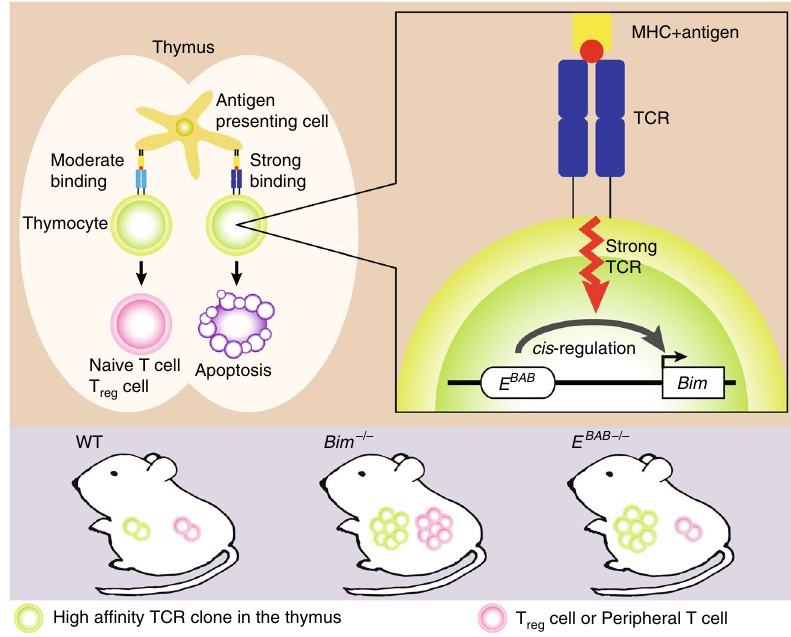
Fig. 9 Graphical summary. E BAB plays a role in inducing TCR signal-dependent apoptosis to eliminate high af fi nity TCR clones in the thymus while dispensable for Bim -dependent peripheral T cell